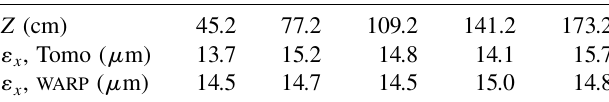
TABLE II. Beam emittances at different positions along the beam line as calculated from the phase spaces generated by tomography and WARP